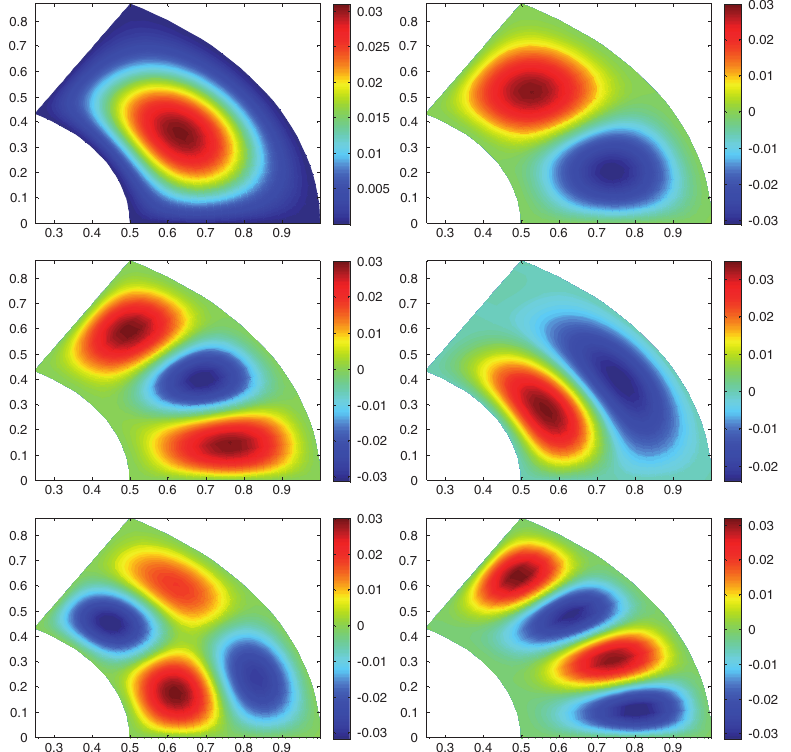
Figure 13 The first six mode shapes of a fully clamped orthotropic FGM annular sector plate for n = 0.1 and θ = 60 ° .